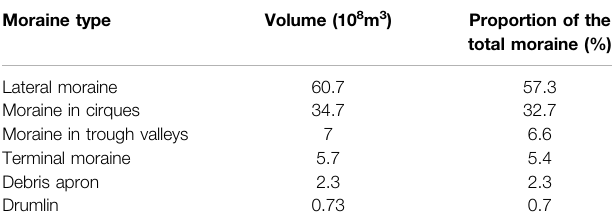
TABLE 2 | The volume of different types of moraine in study